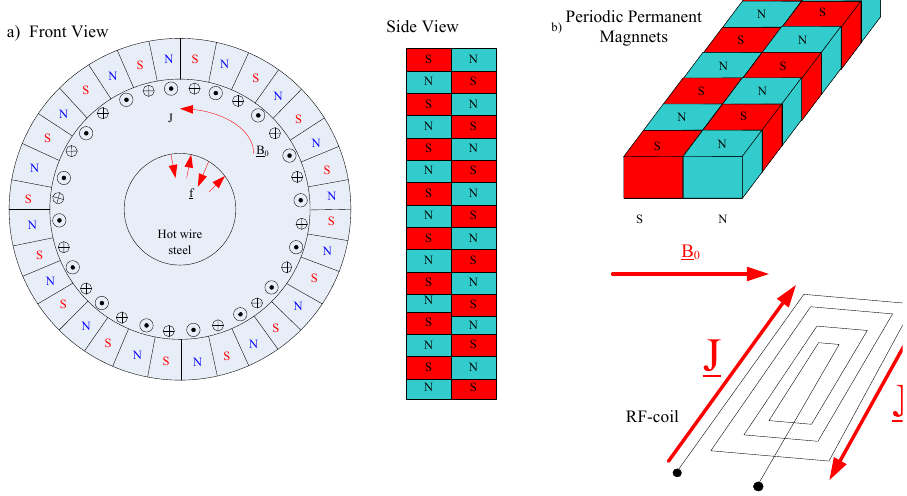
Figure 15. ( a ) Sketch of a Rayleigh wave EMUS probe for hot wire inspection; ( b )